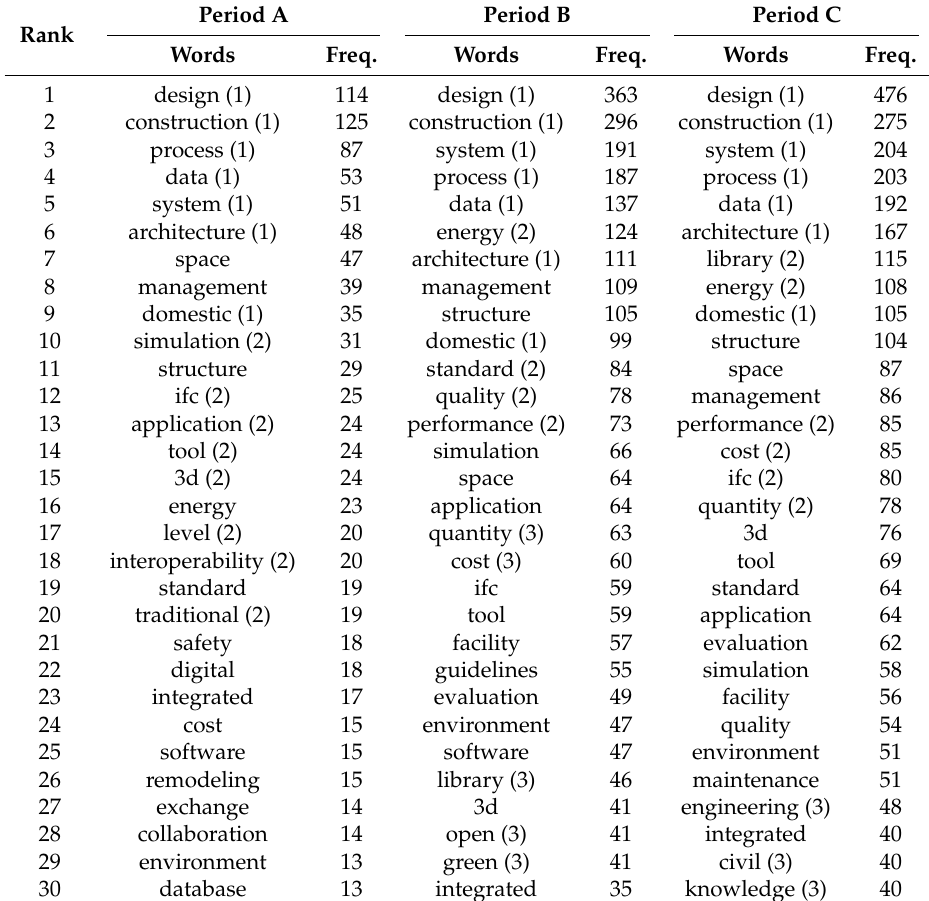
Table 4. Frequency analysis (Period, Top